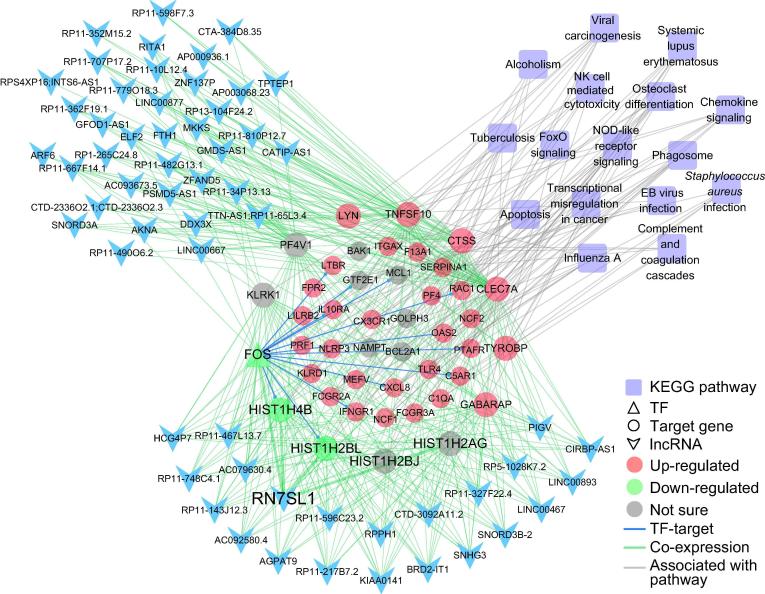
TF–gene–lncRNA co-expression regulatory network containing the largest number of lncRNAs enriched in immune related pathwaysModules were detected by weighted correlation network analysis (WGCNA) using protein-coding genes and lncRNAs. The turquoise-colored module contains the largest number of lncRNAs and functionally enriched in the immune related pathways. TFs and their target gene(s) are indicated in triangles and circles, respectively. Genes up-regulated and down-regulated in all patients are indicated in red and green, respectively, whereas genes with an opposite expression tendency among patients are indicated with gray circles. lncRNAs are indicated with blue arrowheads and KEGG pathways are indicated with purple quadrangles. Edges indicating TF-target regulation, co-expression, and links between genes and pathways are shown in blue, green, and gray, respectively.